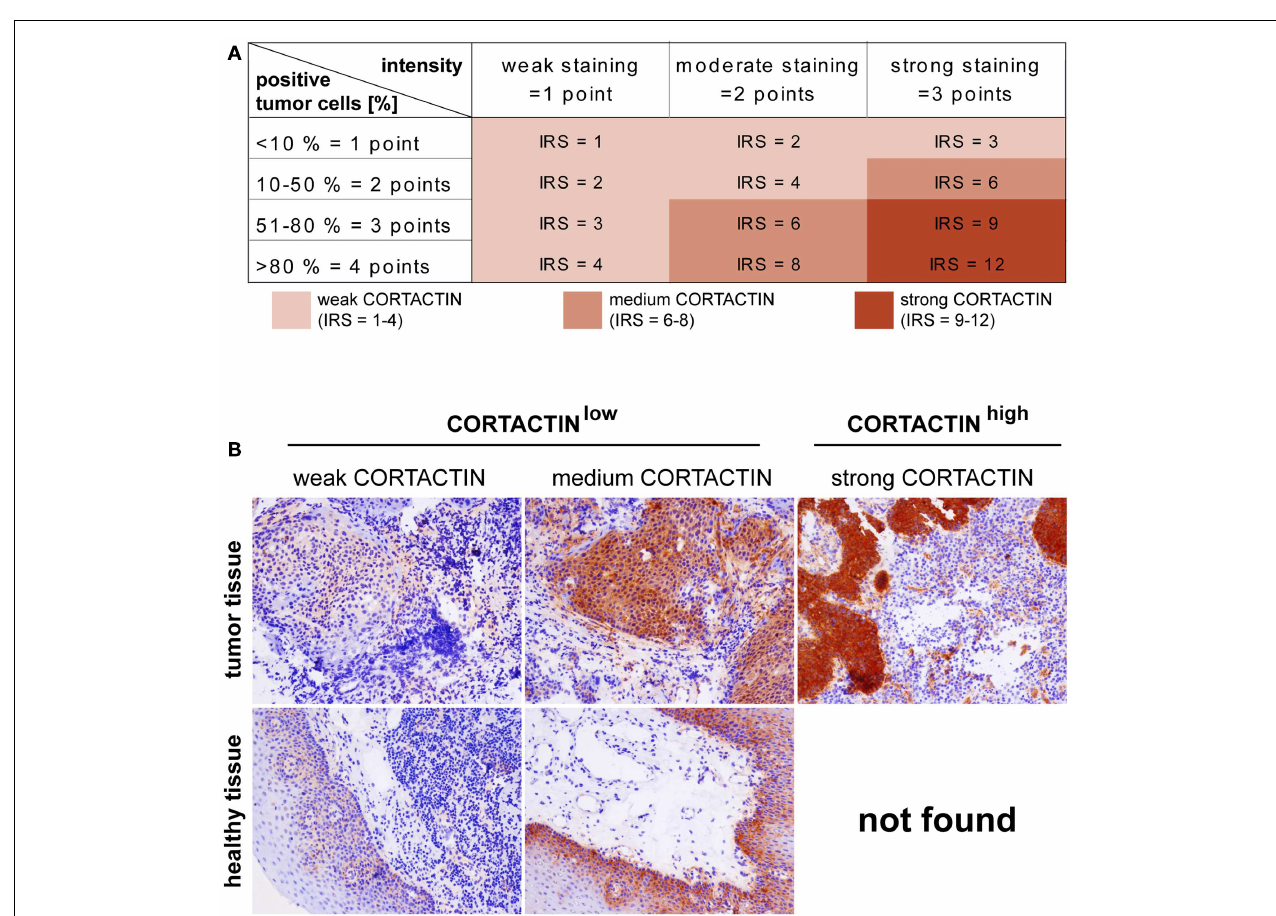
strong levels of CORTACTIN are found only in malignant tissues, while healthy epithelial tissues displayed either weak or medium levels of CORTACTIN. Subsequently, the weak and medium CORTACTIN- expressing specimens were considered as “CORTACTIN low ” while strong CORTACTIN-expressing specimens were termed “CORTACTIN high .” Magnification = 200 ×